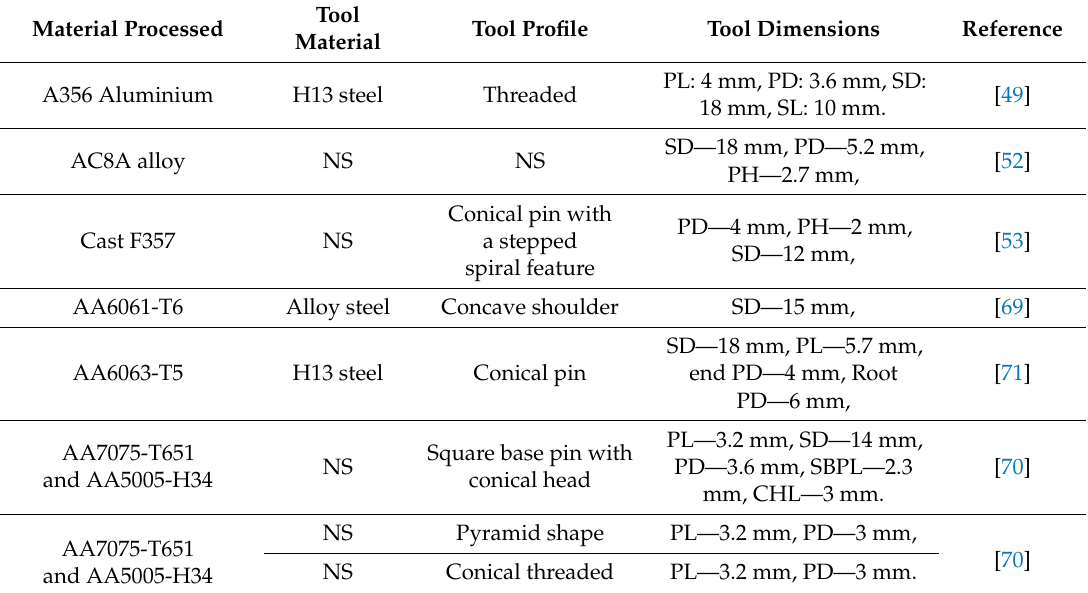
Table 4. Typical FSP tools. (PL—Pin length, PD—Pin diameter, SD—Shoulder diameter,